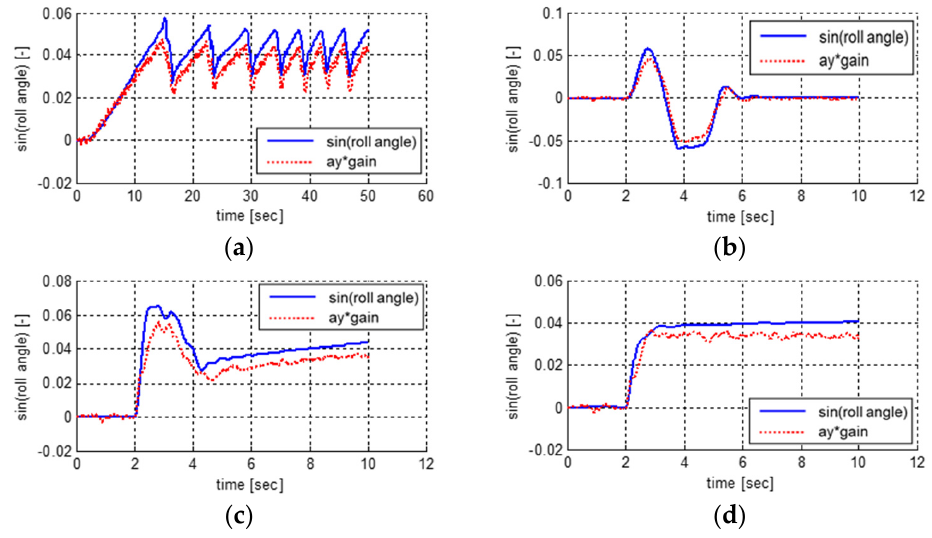
φ and ka : ( a ) Slowly increasing steering maneuver; ( b ) Sine with Dwell test; Figure 4. sin Figure 4. sin φ v and ka y , meas : ( a ) Slowly increasing steering maneuver; ( b ) Sine with Dwell test; v , y meas ( c ) 120 deg step steer; ( d ) 60 deg step steer. ( c ) 120 deg step steer; ( d ) 60 deg step steer.